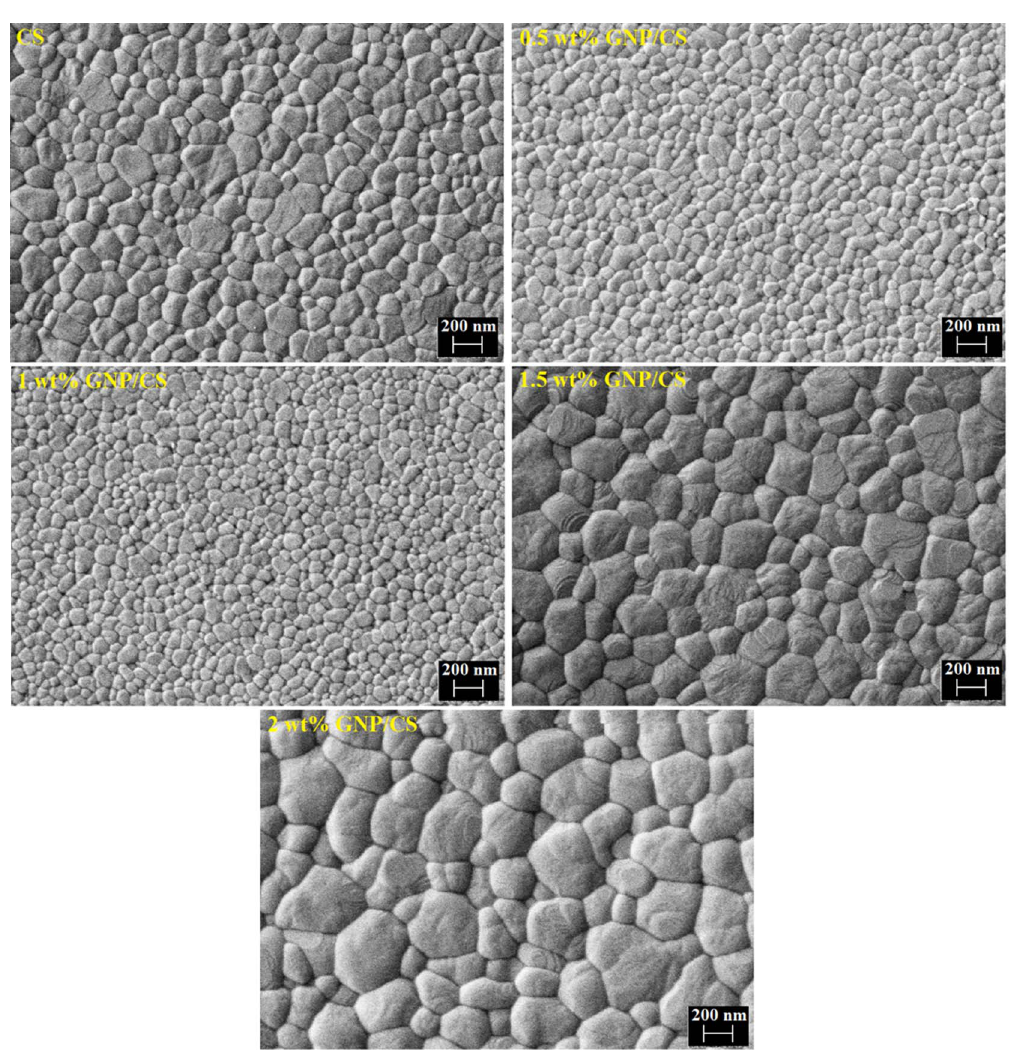
Figure 5. FESEM images of thermally etched surfaces for pure CS and GNP/CS composites.